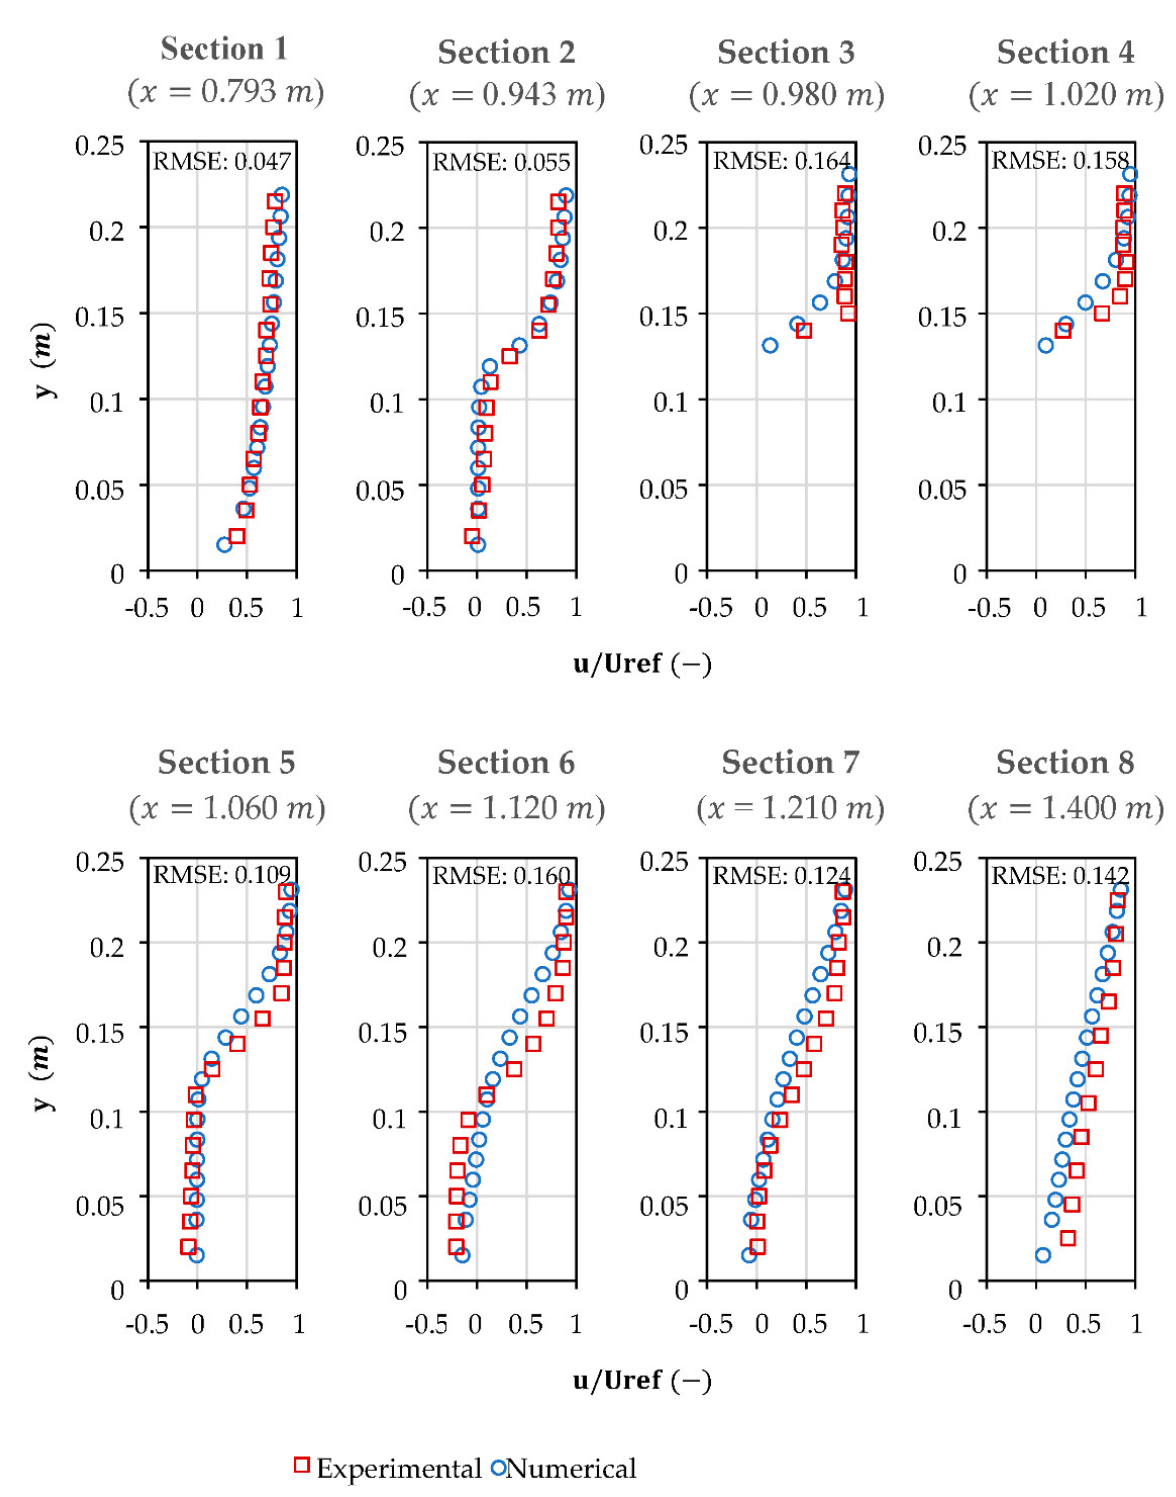
Figure A4. Comparisons between the wind-tunnel measurements performed by Leitl and Schatzmann [28] and the numerical model predictions of the vertical velocity profiles derived from eight different sections locating on the symmetry plane, z = 0.325